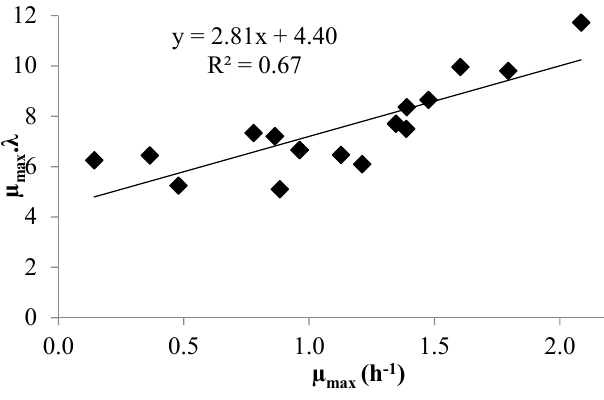
Figure 3. μ ma x · λ as a function of μ max for L. brevis. Figure 3. µ ma x · λ as a function of µ max for L. brevis.